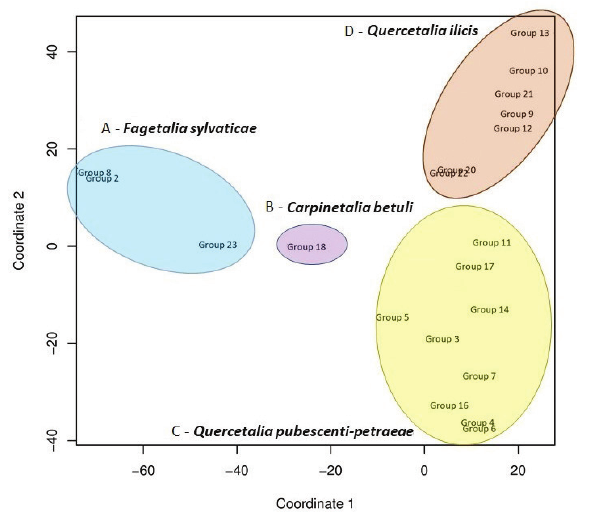
Figure 1. Kruskal’s NMDS ordination of the vegetation groups. Due to the high number of plots only the cen- troids of the groups are shown. Stress values of the two components are 0.32 and 0.18,